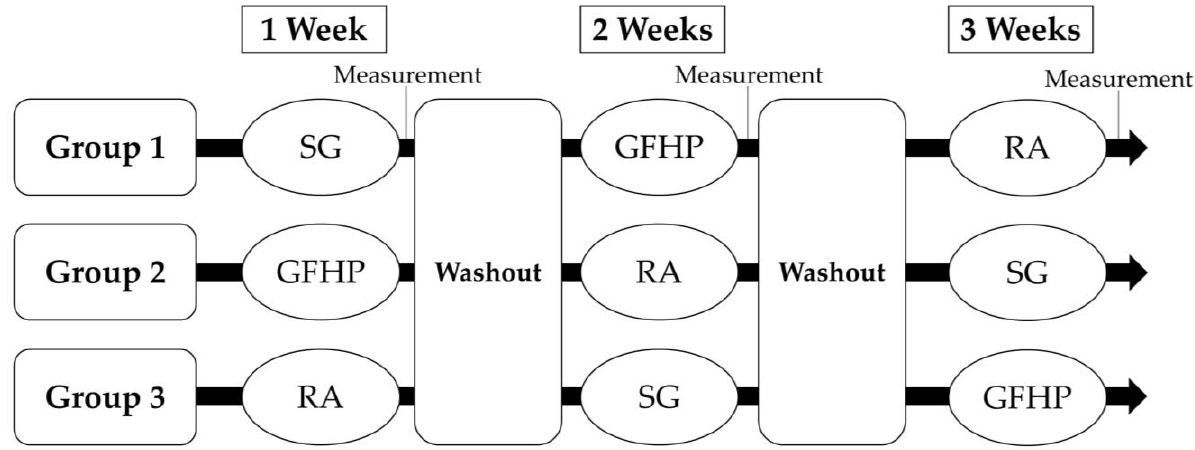
Figure 1. Design of the experiment. SG, self-guided forest healing program; GFHP, guided forest- healing program; RA, routine activities without any intervention.